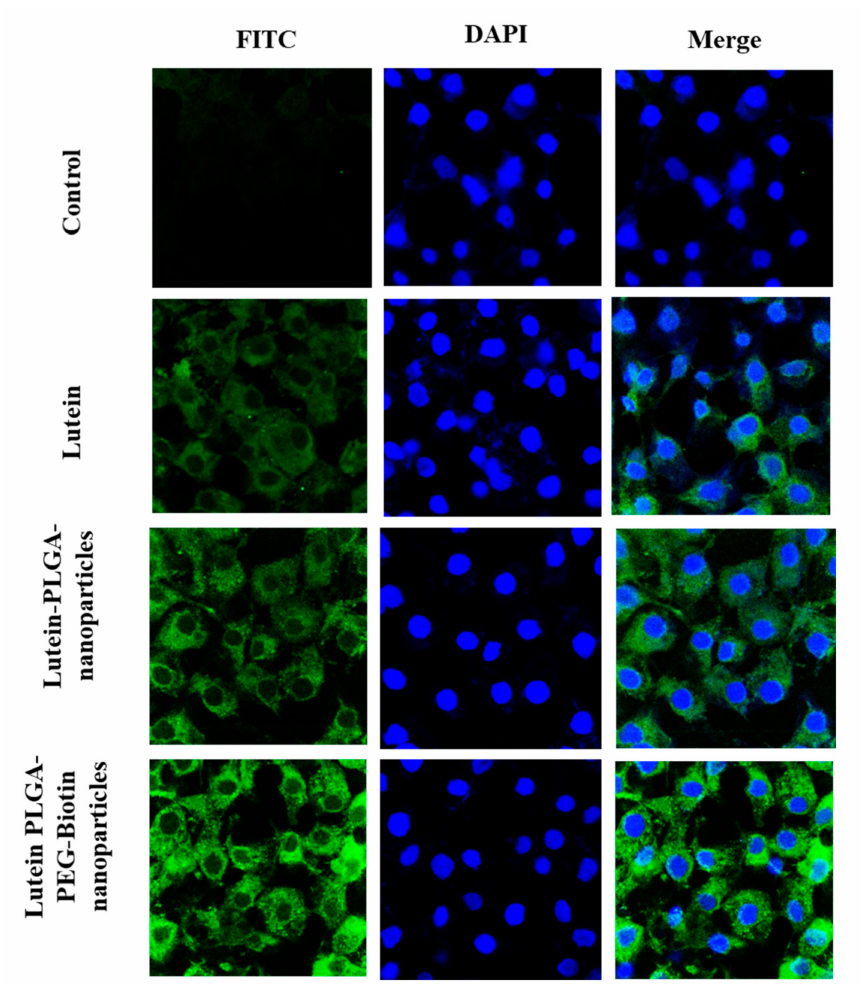
Figure 8. Confocal laser scanning microscopy images of FITC-labelled lutein and FITC-labelled lutein polymeric nanoparticles (PLGA and PLGA–PEG–biotin) at 12 h in ARPE-19